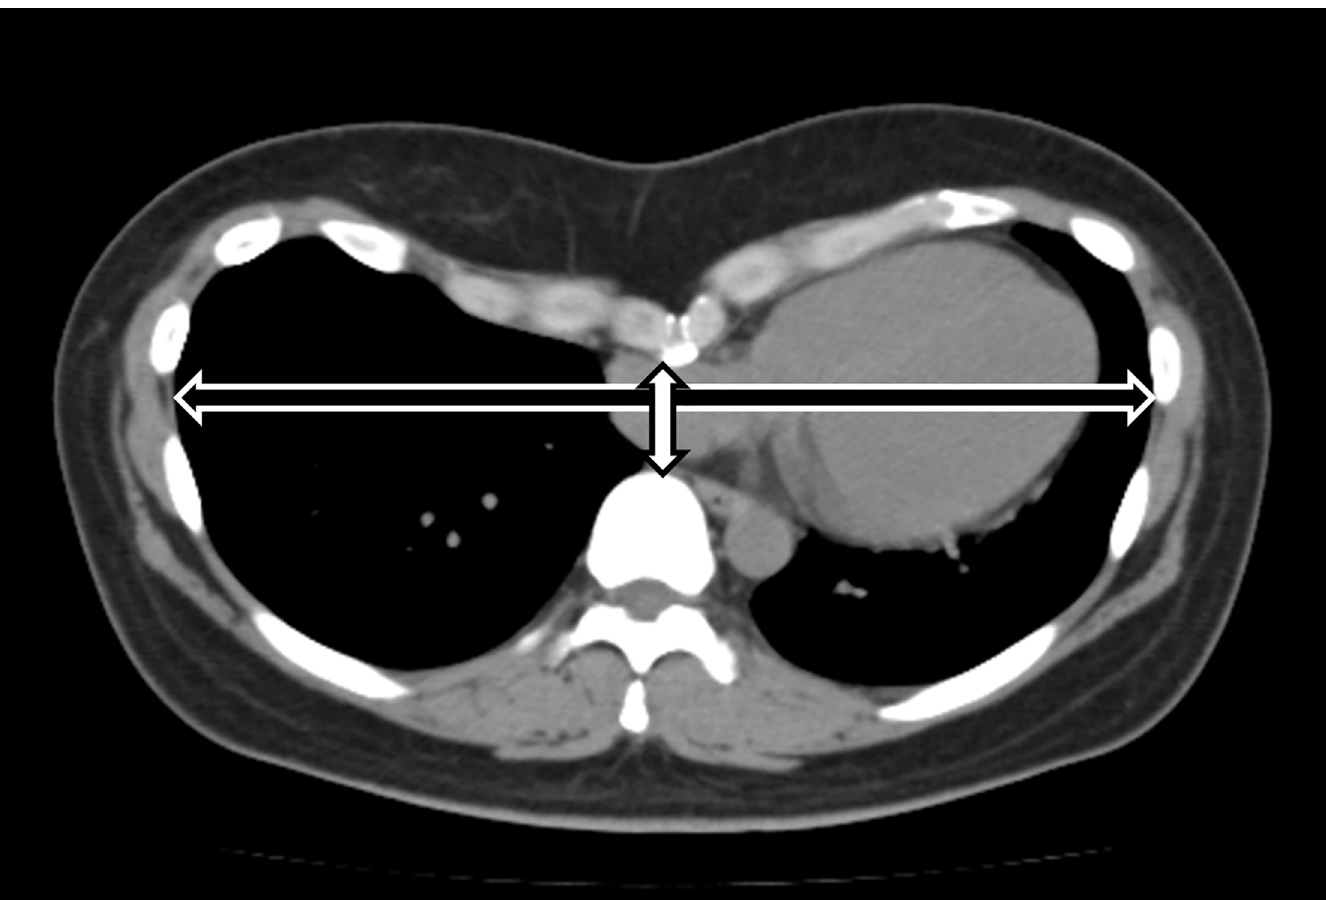
Fig 3. Measurement of the Haller computed tomography (CT) index. The Haller CT index was calculated by dividing the thoracic transverse diameter (black bidirectional arrow) by the distance between the sternum and the vertebra (white bidirectional arrow).